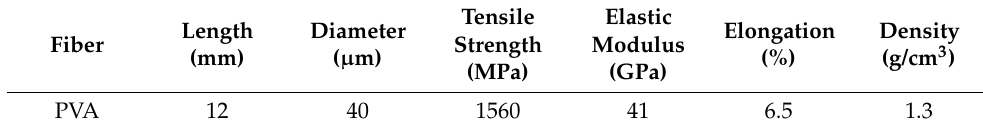
Table 2. Performance indicators of